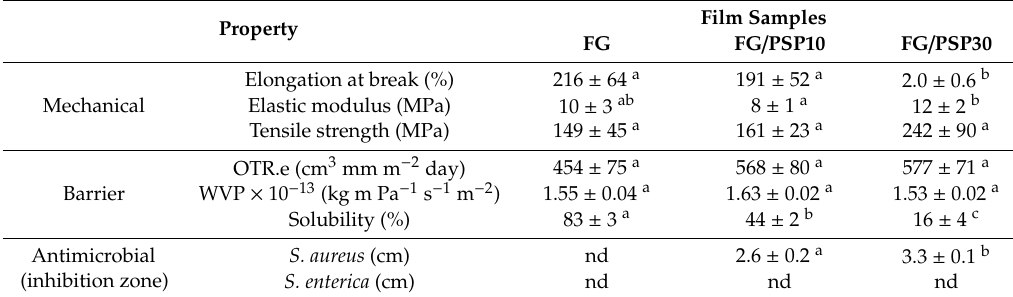
Table 5. Mechanical ( n = 5), barrier ( n = 3) and antimicrobial ( n = 3) properties of fish gelatin films with PSP (mean ±